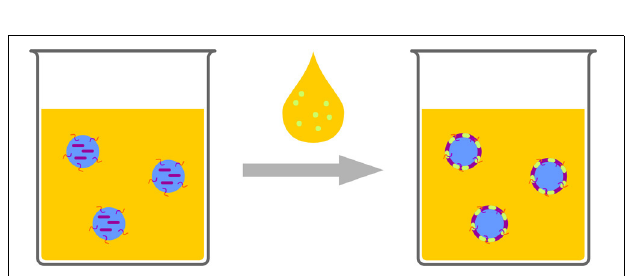
FIGURE 10 | Schematic representation of interfacial reactions in inverse emulsion. One monomer (purple) is provided in the aqueous droplets, the other one (light green) is added, dissolved in solvent. The reaction leads to a polymeric shell enclosing the water